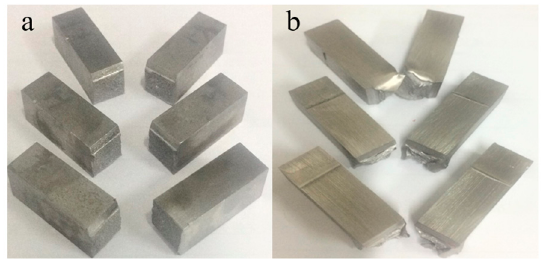
Figure 15. Impact samples. ( a ) Impact samples for one time welding. ( b ) Impact samples for pre-heating, welding and post-heating.